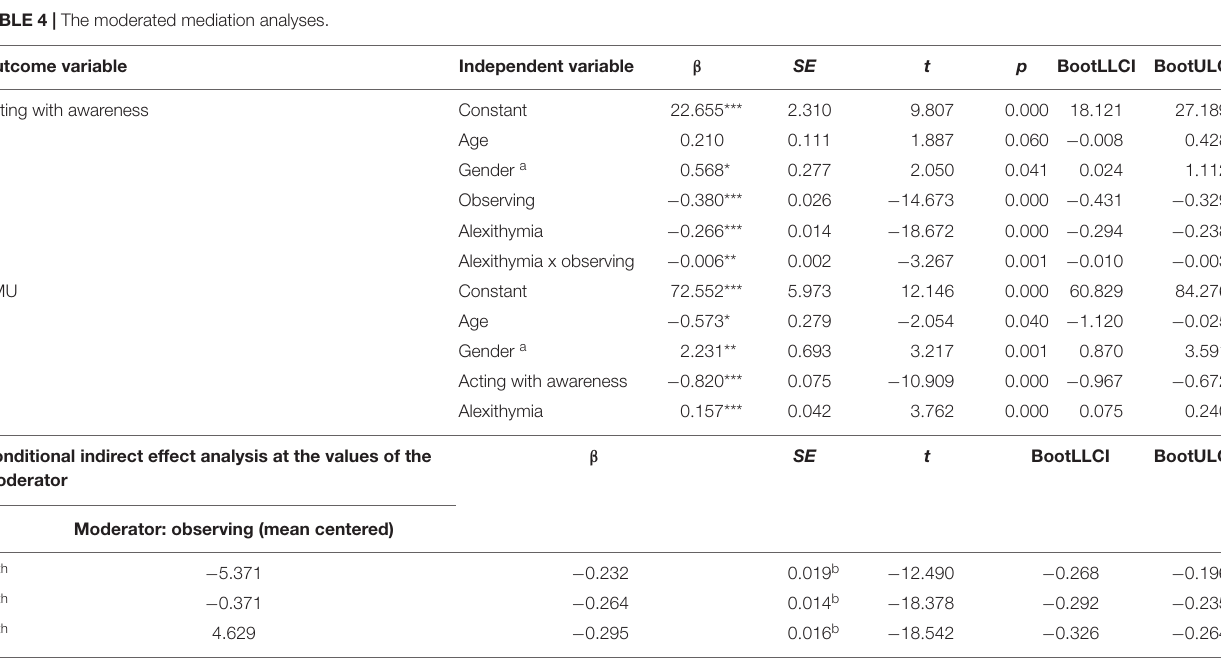
TABLE 4 | The moderated mediation